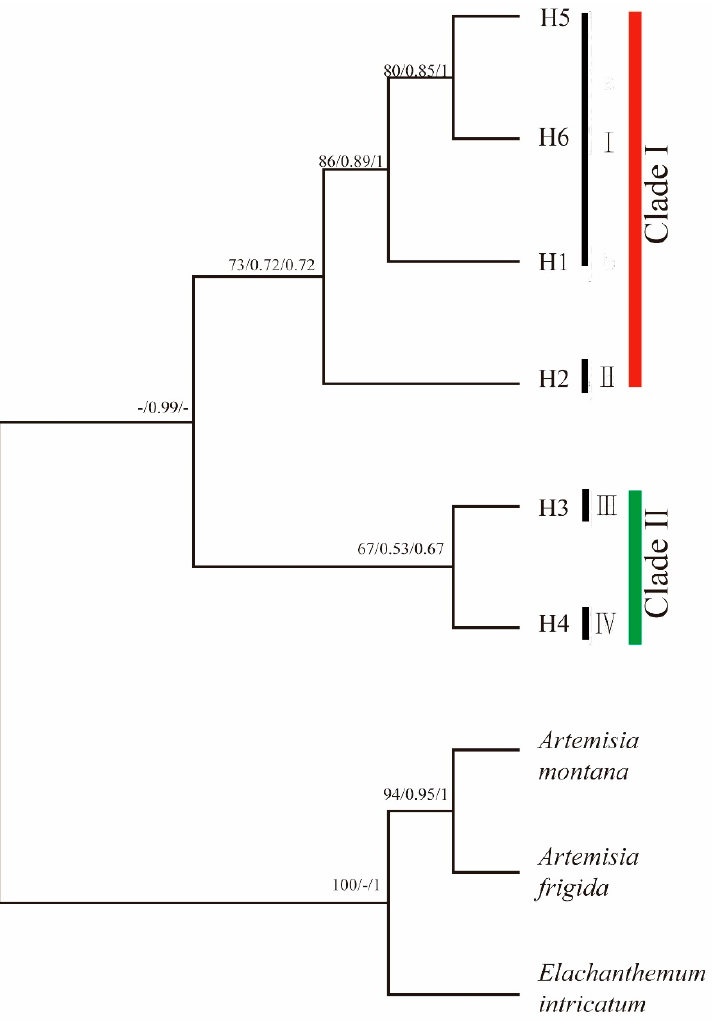
Figure 2. Phylogenetic relationships of the identified haplotypes of Stilpnolepis centiflora using Elachanthemum intricatum , Artemisia montana, and Artemisia frigida as outgroups by neighbor-joining method. Neighbor-joining bootstrap values are shown above branches.